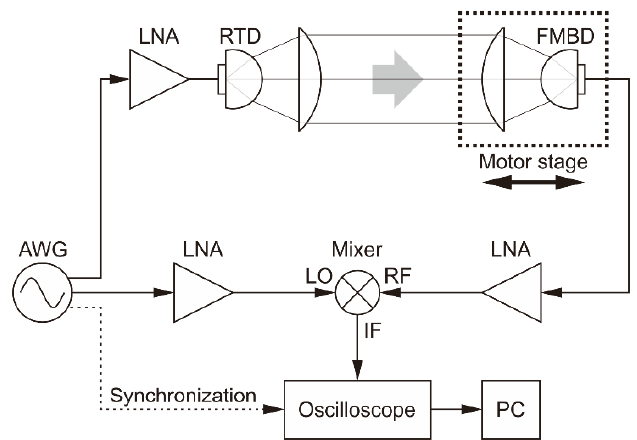
Figure 2. Schematic of the electrical and in-line optical setup. AWG: arbitrary waveform generator, LNA: low-noise amplifiers for power level adjustment and detected signal enhancement. In this particular optical configuration, the radar only measures the propagation distance between the terahertz source and detector. To change the propagation distance, the detector and its lens (marked by a dotted rectangle) are moved together as a unit. Auxiliary circuit elements such as power supplies, a bias tee, etc. are omitted for simplicity.